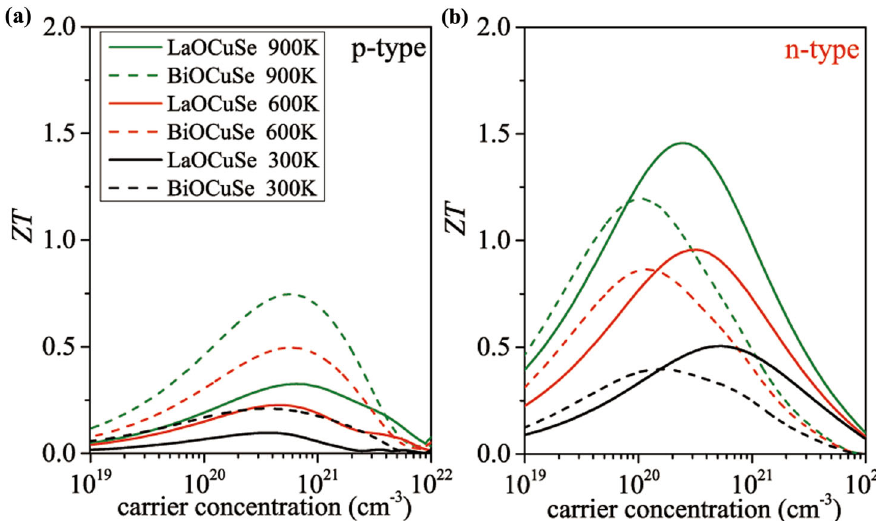
Fig. 7 Thermoelectric conversion ef fi ciency. The fi gure of merits ZT ( a , b ) for LaCuOSe and BiCuOSe as a function of carrier